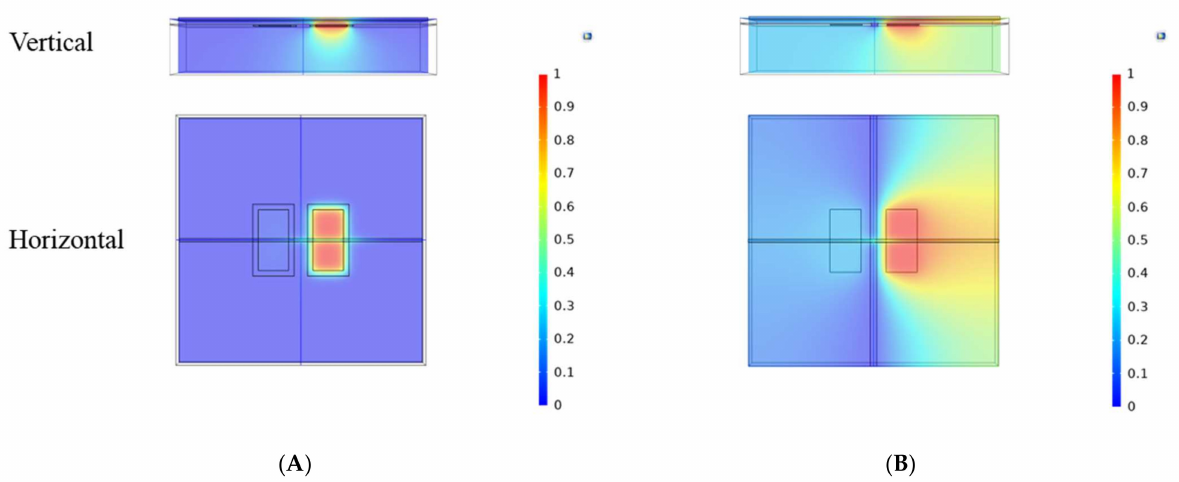
Figure 2. Simulated electric potential distribution of C4D cell, with both vertical and horizontal direction. A model ( A ) with PG-C4D feature and ( B ) with traditional C4D